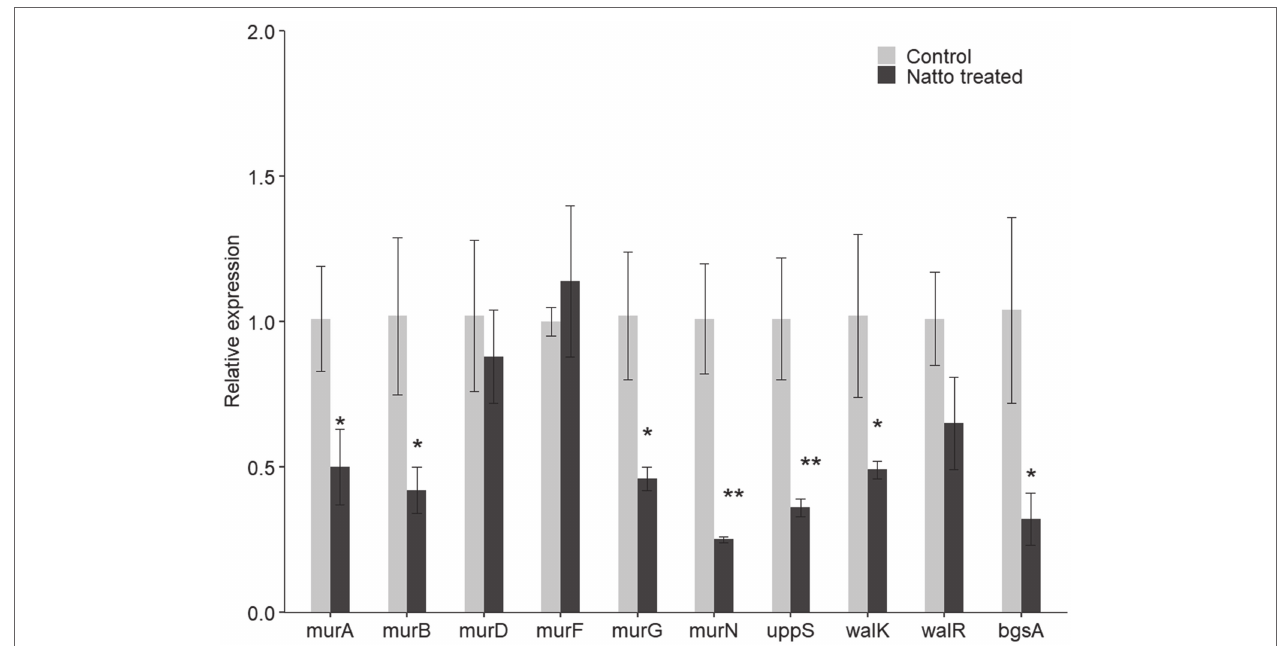
FIGURE 8 | B. subtilis natto supernatant inhibits E. faecalis cell wall- and biofilm-related genes. E. faecalis OG1RF was cultured anaerobically in the presence or absence of B. subtilis natto supernatant for 24 h. The relative expression of genes in the peptidoglycan biosynthesis pathway (murA, murB, murD, murF, and uppS), genes in the WalK/WalR two-component system (walK and walR), and bgsA were assessed using RT-qPCR. The data are presented as the means ± SDs ( n = 3). * p < 0.05 and ** p < 0.01 compared with each negative control group (Student’s t